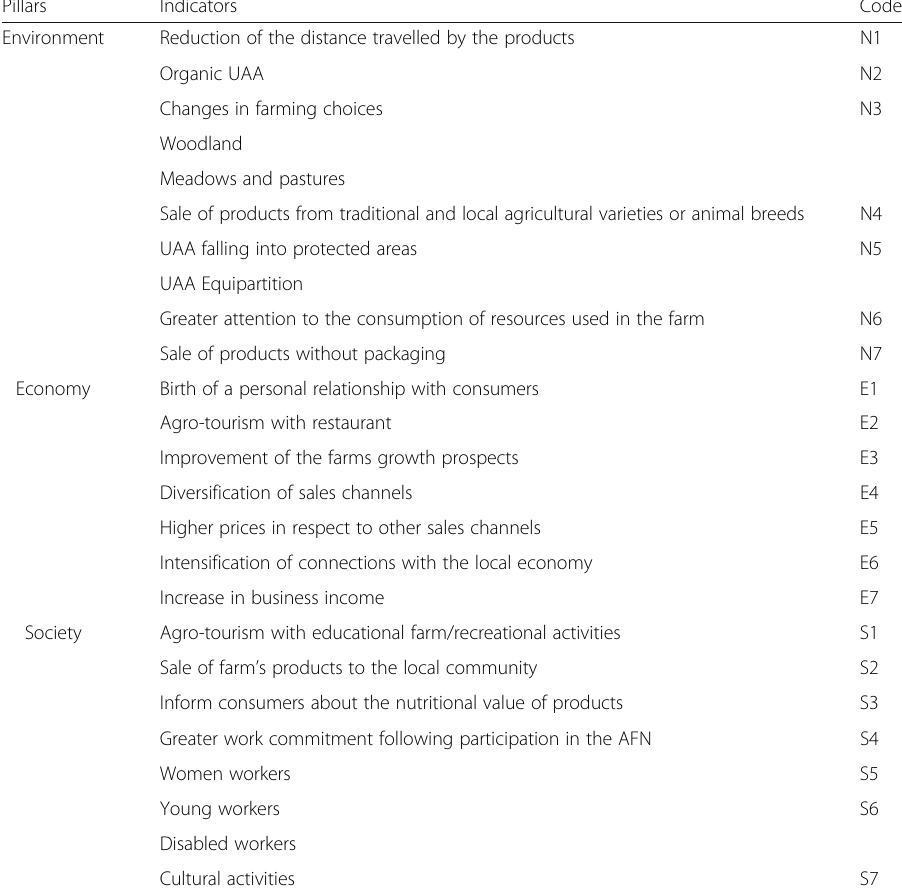
Table 1 List of the available indicators starting from the complete list of the Global Sustainability Index